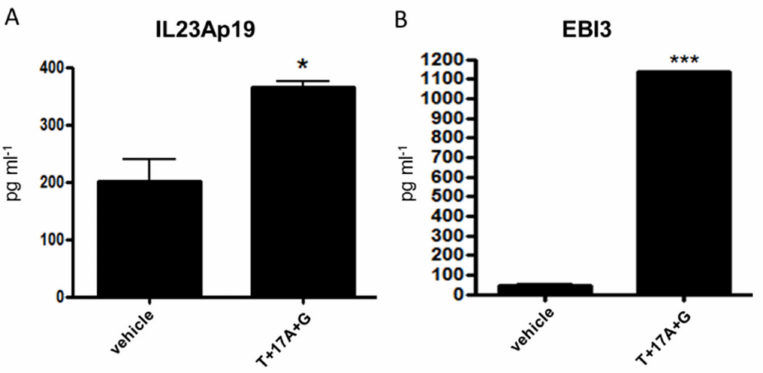
Figure 4. Analysis of IL-23Ap19 and EBI3 protein expressions in epidermal keratinocytes. Normal human epidermal keratinocytes (NHEKs) were stimulated with the triple combination of TNF- α (50 ng/mL), IL-17A (50 ng/mL) and IFN- γ (50 ng/mL) for 24 h. ELISA was used to measure protein levels of ( A ) IL-23Ap19 and ( B ) EBI3. * p < 0.05, *** p < 0.001. T, TNF- α ; 17, IL-17A; G, IFN- γ .